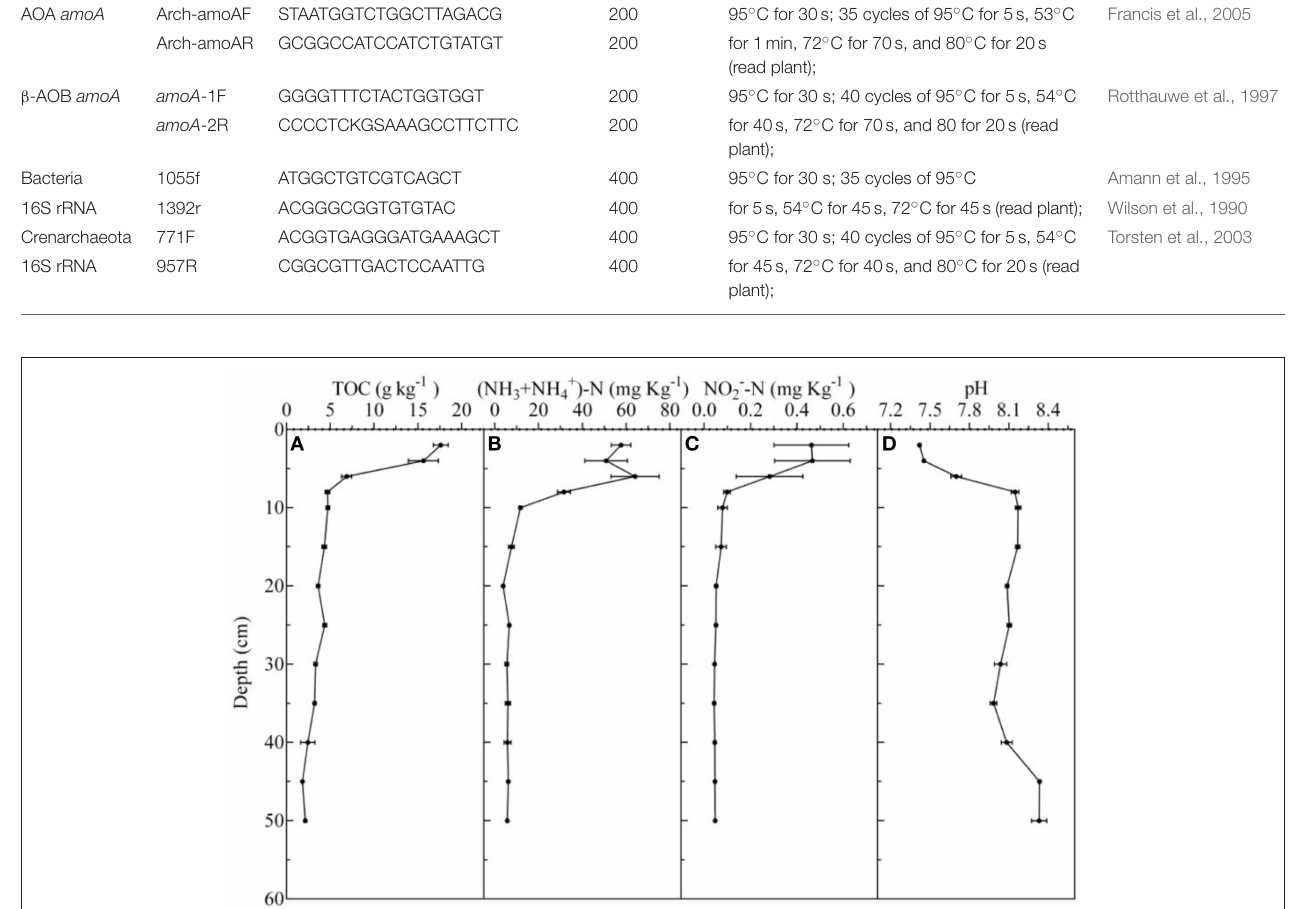
FIGURE 1 | Vertical distribution of total organic matter (A), ammonia nitrogen (B), nitrite nitrogen (C), pH (D), which was detected in October 2014.